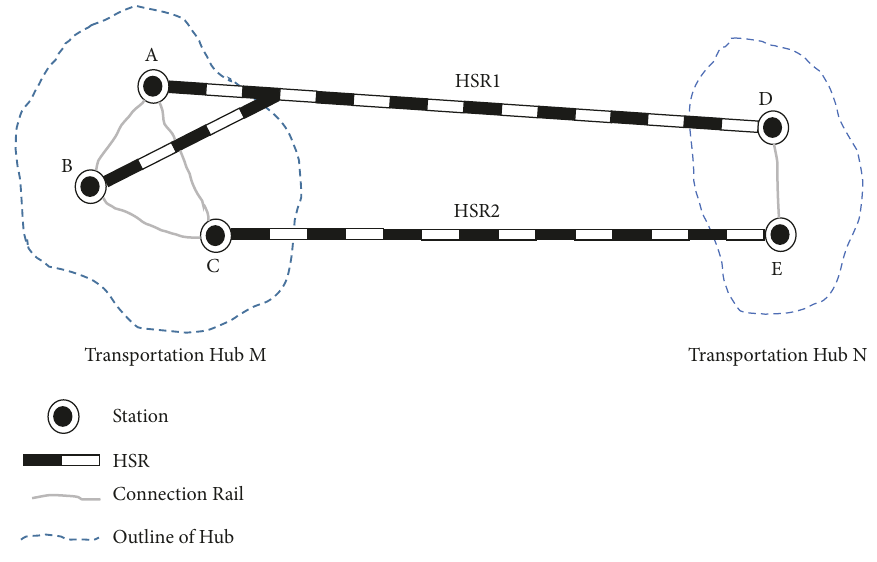
Figure 2: Topological structure of